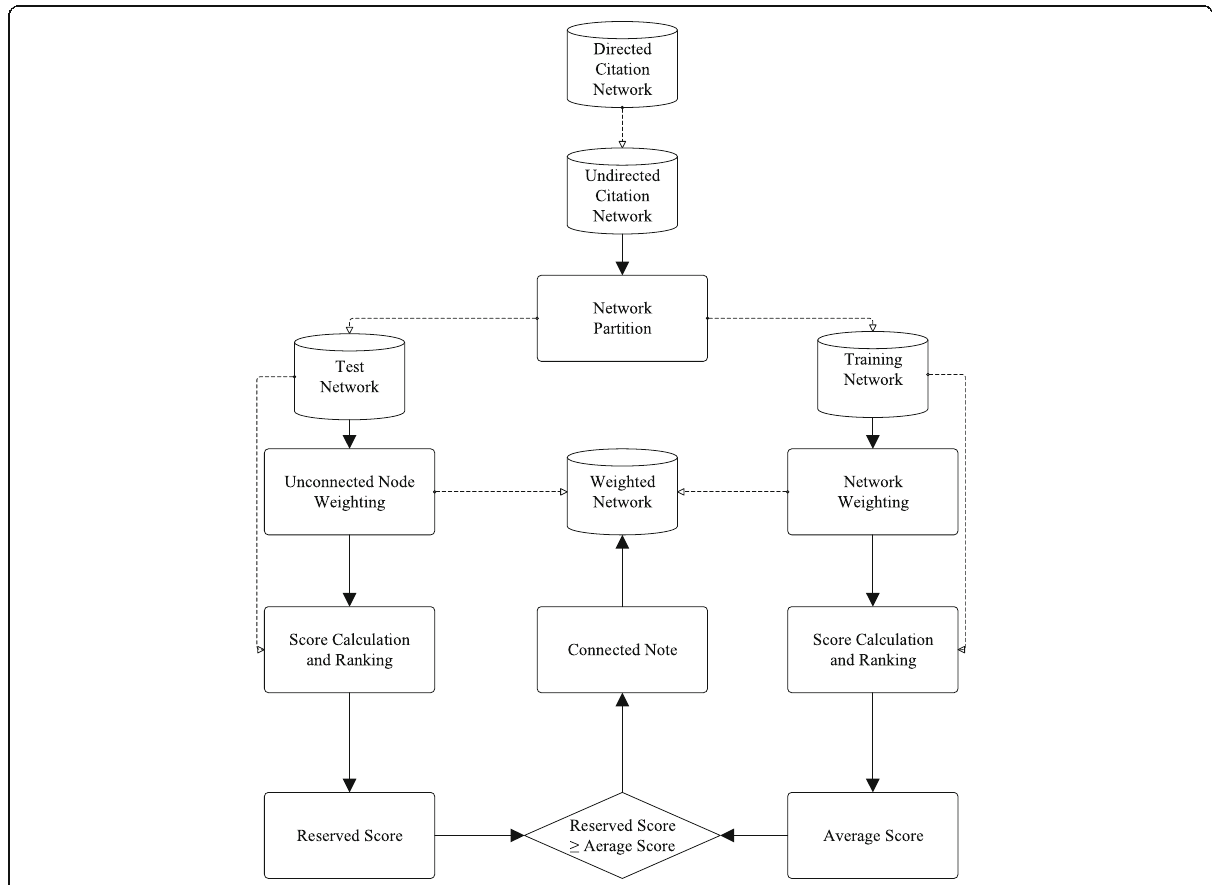
Fig. 3 Process for weighting-based link